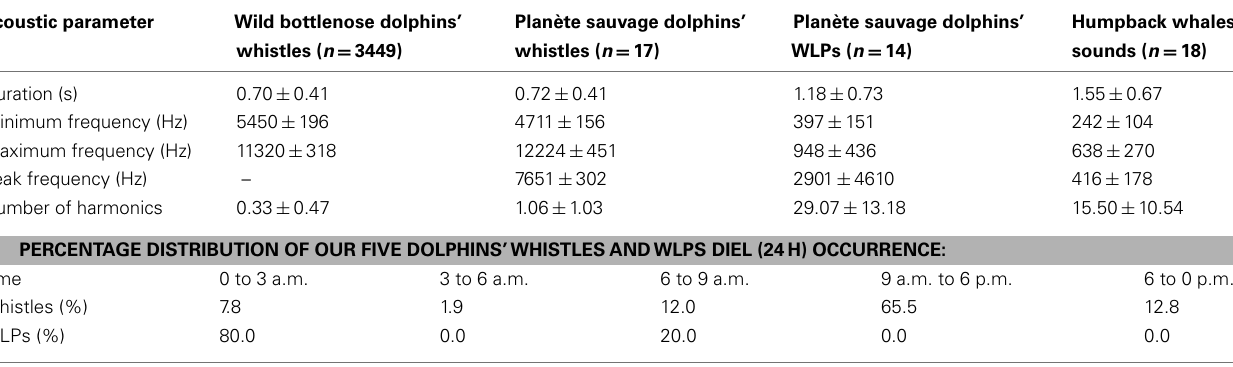
Table 1 |Acoustic parameters and recording times of dolphins’ and humpback whales’ vocalizations.